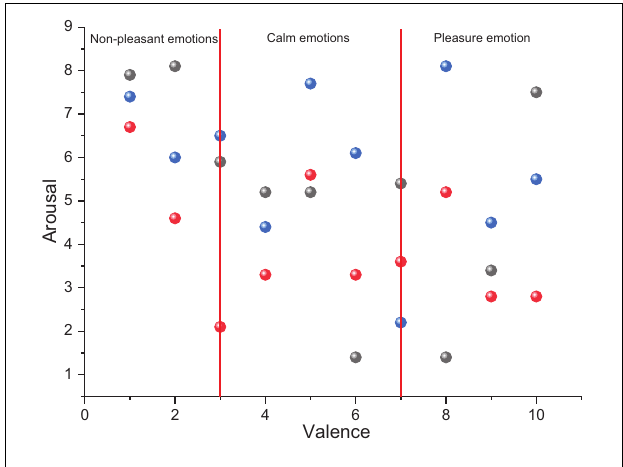
FIGURE 3 | Emotional division